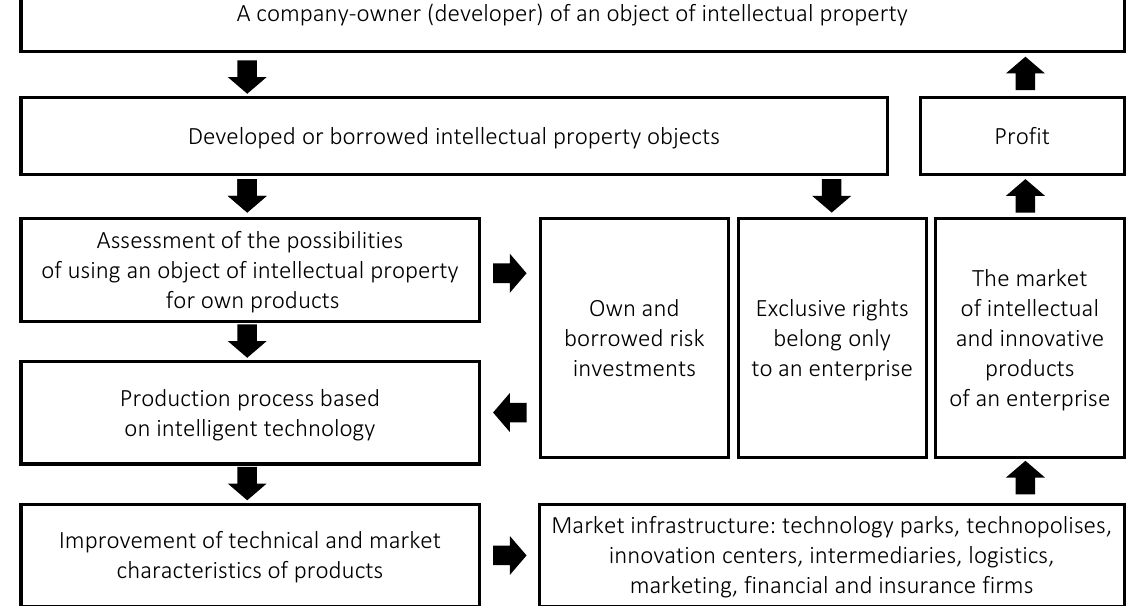
Own and borrowed